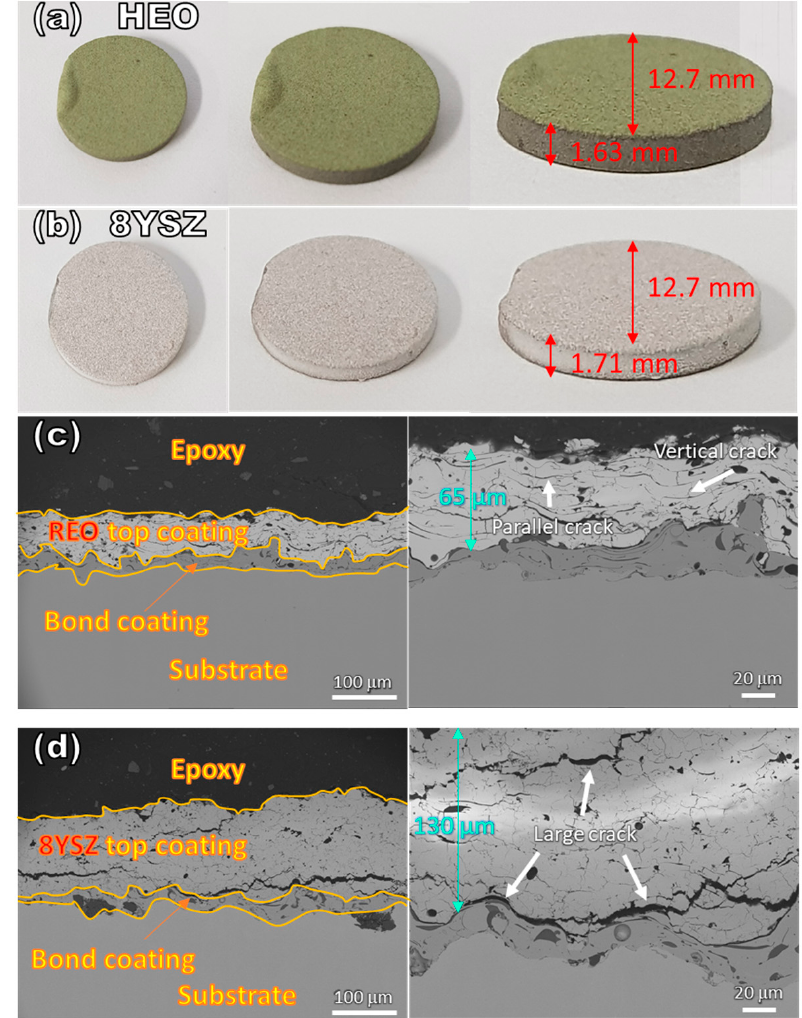
Figure 3. Macroscopic and microscopic images of the thermal barrier coating specimens: ( a , b ) pho- tographs; ( c , d ) cross-sectional SEM images.